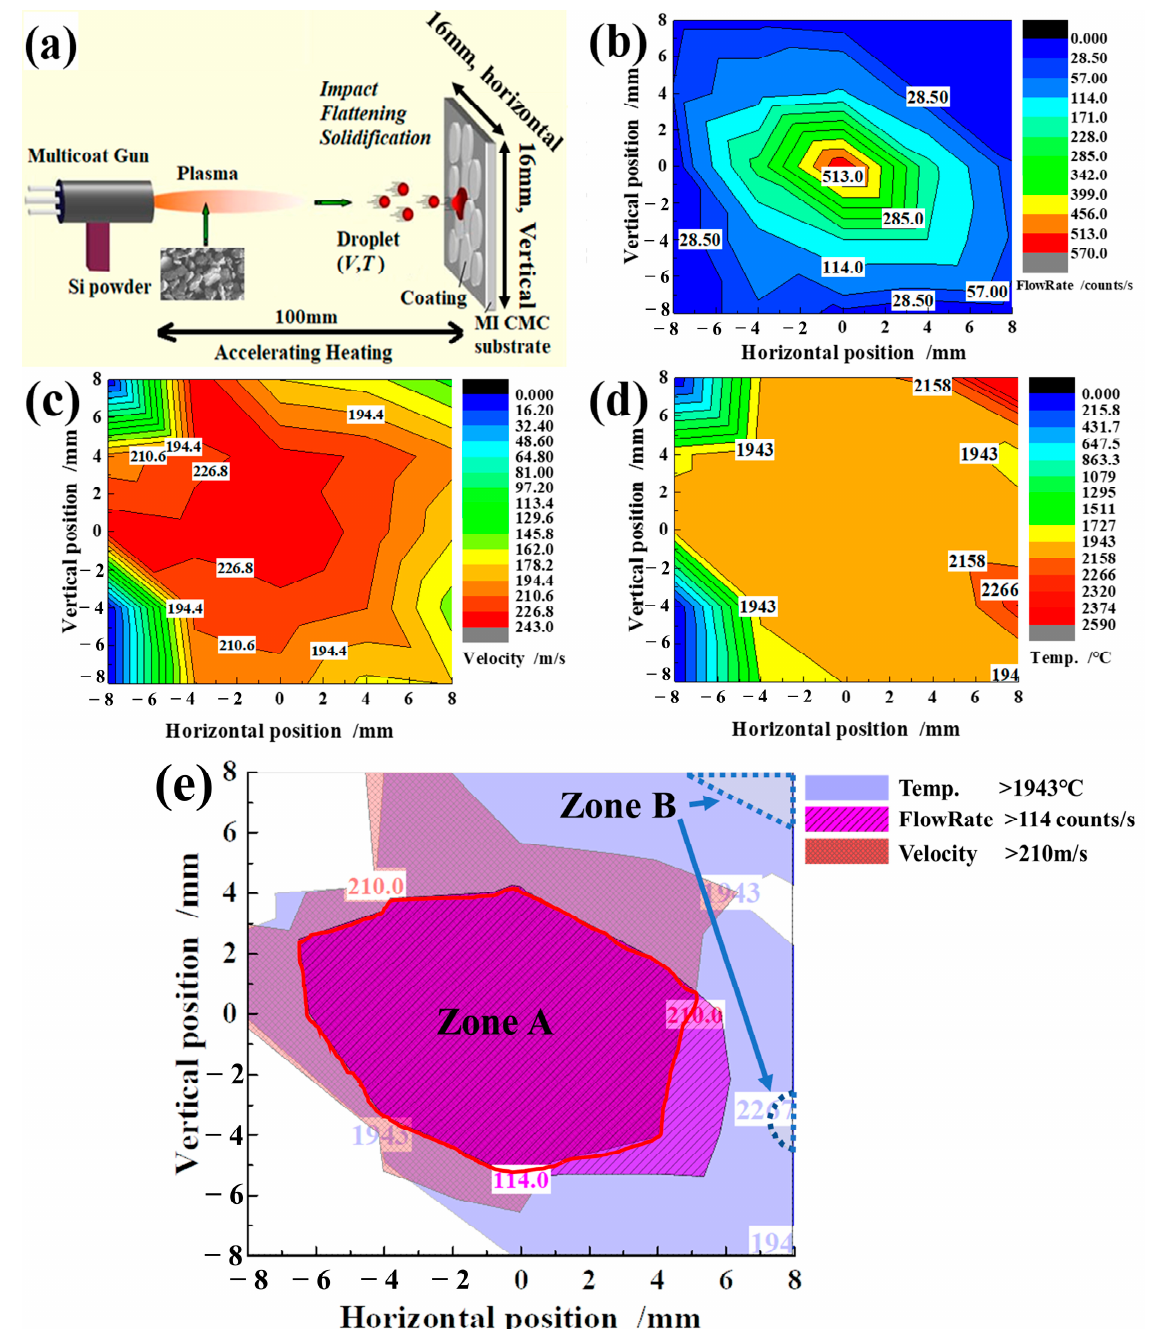
Figure 3. Schematic diagrams of ( a ) the Si layer spraying process and ( b – d ) the properties of in fl ight Si particles measured in a 16 mm × 16 mm rectangle plane, 100 mm away from the spray gun. ( e ) Multi-contour map with several threshold values.